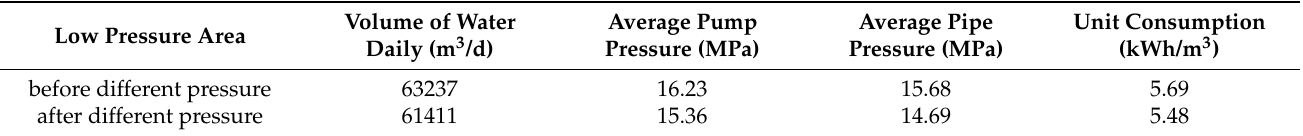
Table 3. Energy consumption of the low-pressure area before and after different pressure in the X oilfield.